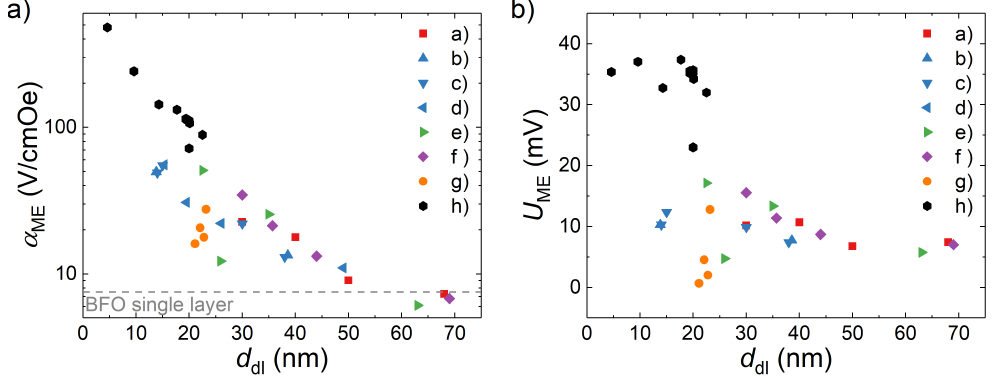
Figure 7. Overview: ( a ) α ME values and ( b ) respective as-measured U ME values measured in 0T at 300K vs. p O for all BTO-BFO multilayers reported in a) [8] ( p O variation); b)-d) [9,12,14] (BFO 2 2 thickness variation); e) [13] (5% Gd substitution, BFO thickness variation); f) unpublished (see Table S1, BFO thickness variation); g) [11] (repetition variation n dl = 2 − 20), and h) this work (BTO-BFO thickness ratio variation, p O variation, and d dl 2